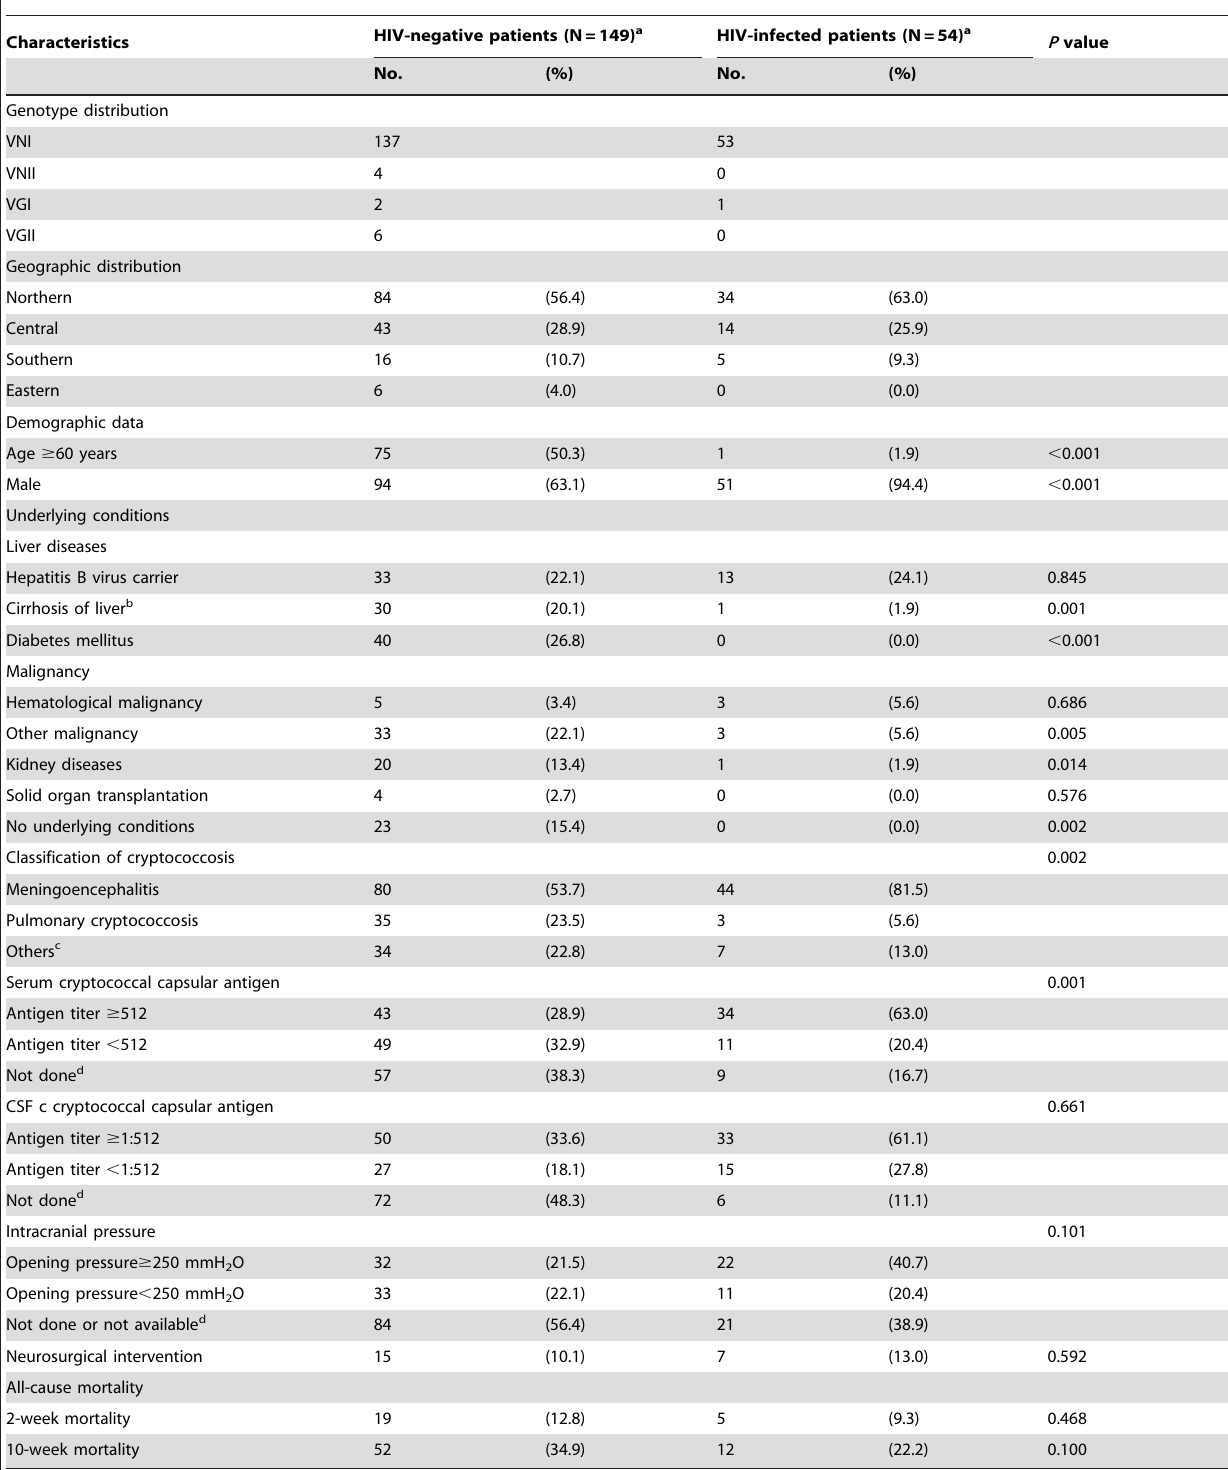
Table 3. Comparisons of genotype distribution and clinical characteristics of cryptococcosis by HIV status, Taiwan, 1997–2010.